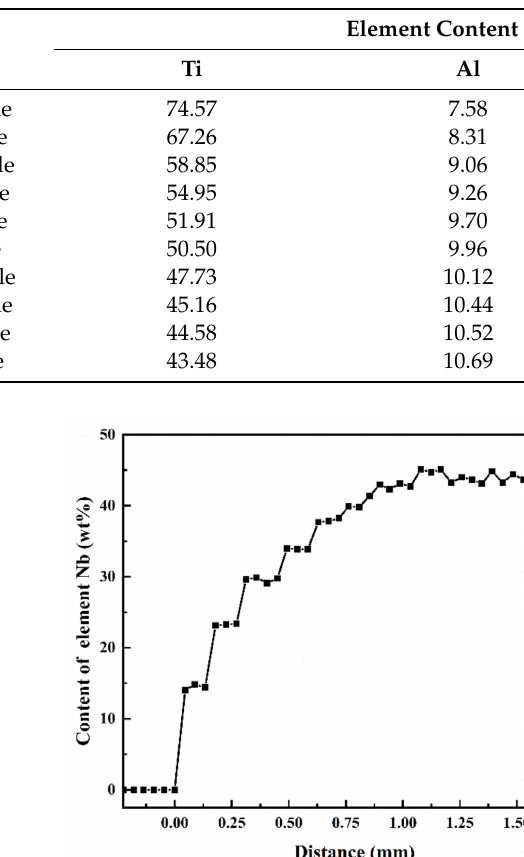
Table 2. Chemical compositions of the last deposited layer in di ff erent deposited layer samples.